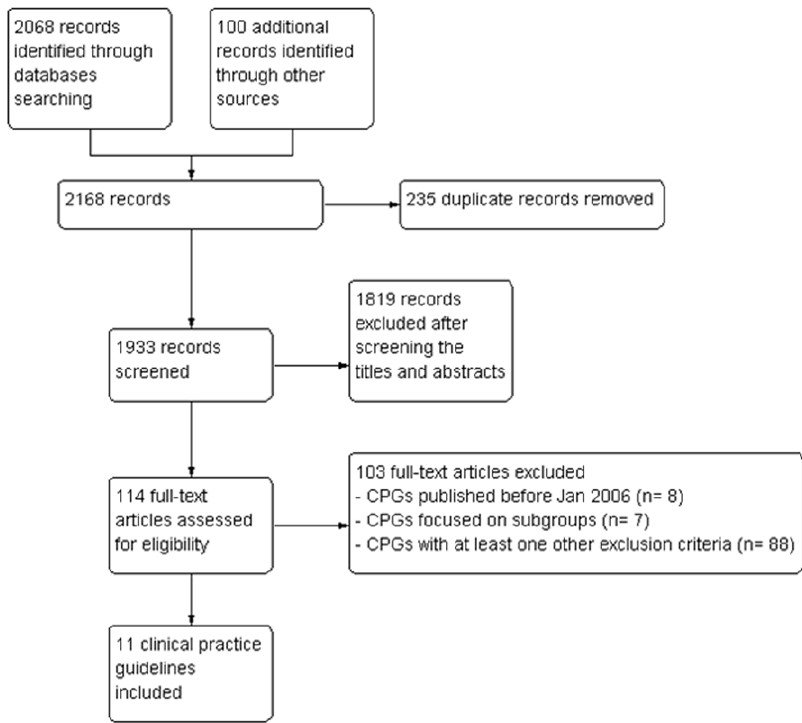
Figure 1. Flow chart using the PRISMA statement for the systematic review.